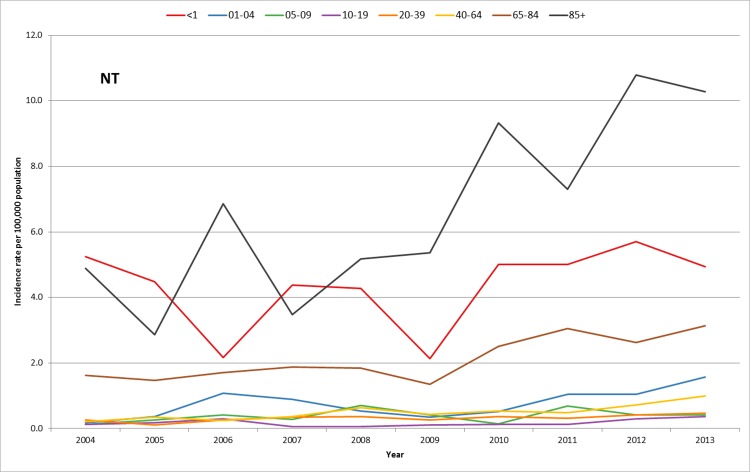
Incidence rate of invasive non-typeable Hi by age group in Ontario, 2004–2013 (n = 990).